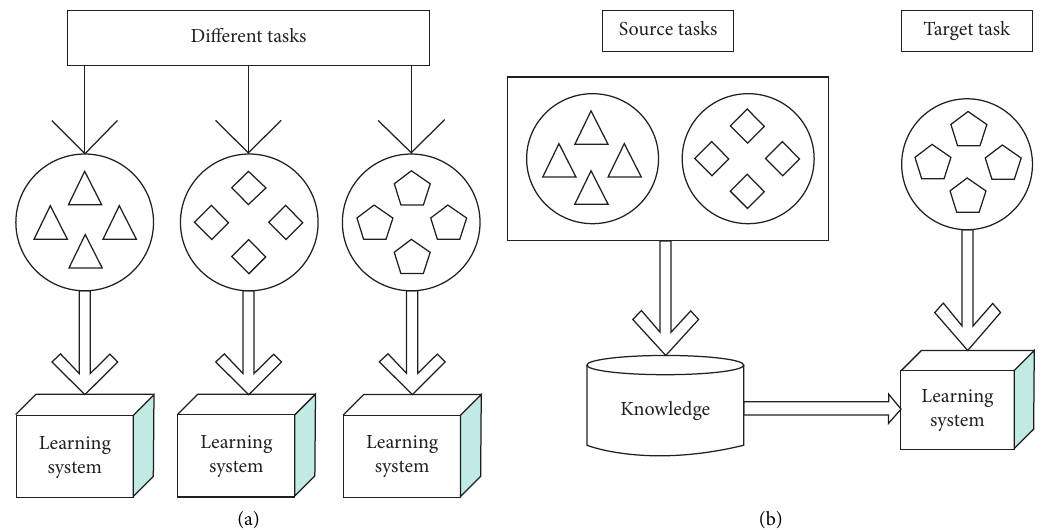
Figure 2: Different learning processes between (a) traditional machine learning and (b) transfer